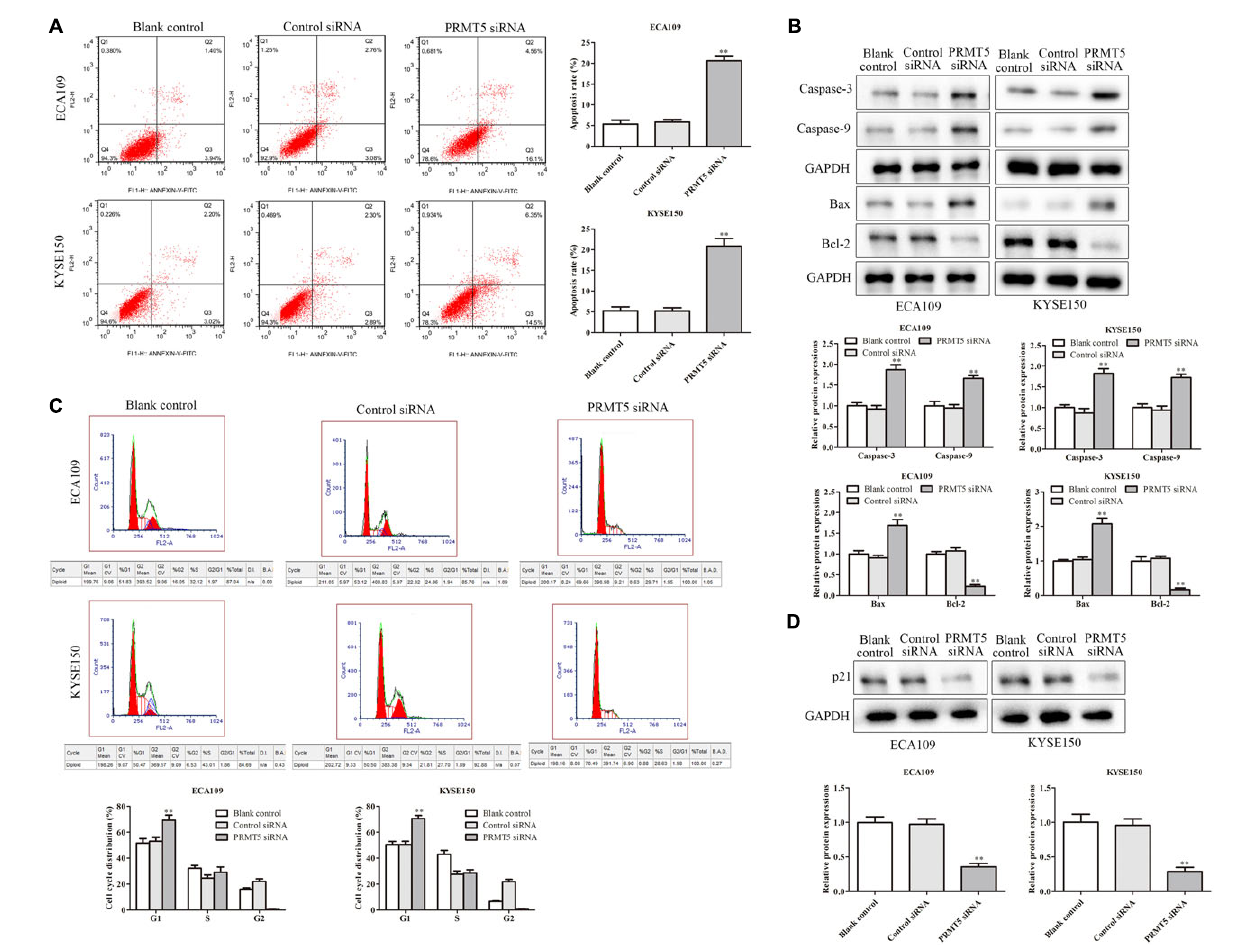
FIGURE 3 | Knocking down PRMT5 promoted ESCC cell apoptosis and induced ESCC cell arrest in G1 phase. (A) The apoptosis rates of ECA109 and KYSE150 cells transfected with siRNA PRMT5 were detected by flow cytometry. (B) The expression levels of caspase-3, caspase-9, Bax, and Bax-2 were analyzed in ECA109 and KYSE150 cells. (C) Knocking down PRMT5 in ECA109 and KYSE150 cells significantly increased the G1 phase of cell cycle compared with the controls. (D) The expressions of p21 were analyzed in ECA109 and KYSE150 cells. GAPDH was used as a control. Bars indicate the mean ± SEM, * P < 0.05, ** P < 0.01 vs. control siRNA. ESCC, esophageal squamous cell carcinoma; PRMT5, protein arginine methyltransferase